Question: What type of chart is this?
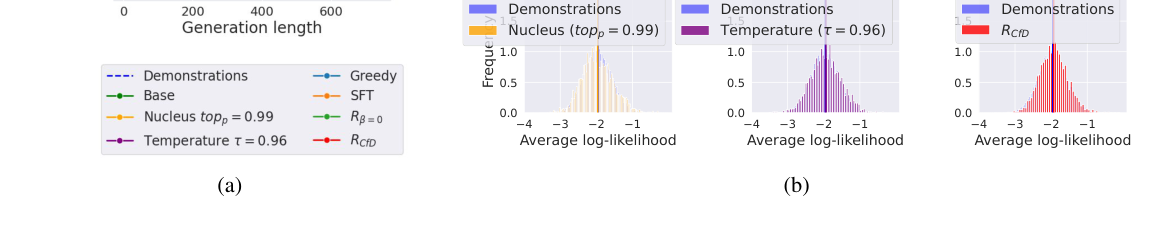
Answer: line